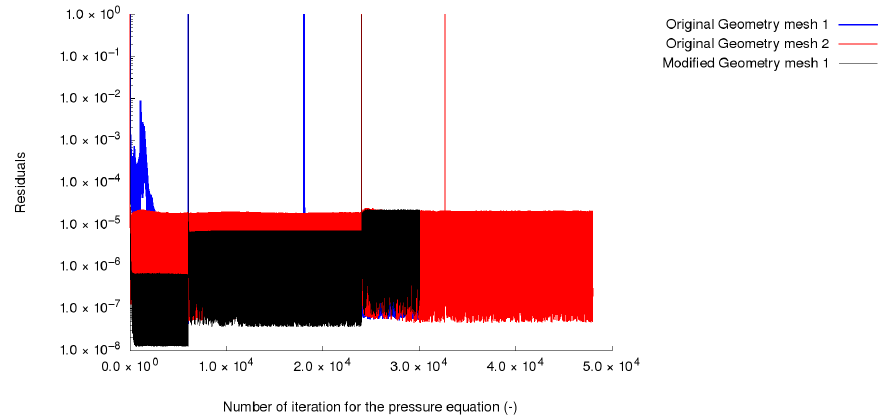
Figure 5. History of the pressure residuals for the three simulations carried out with a stroke of